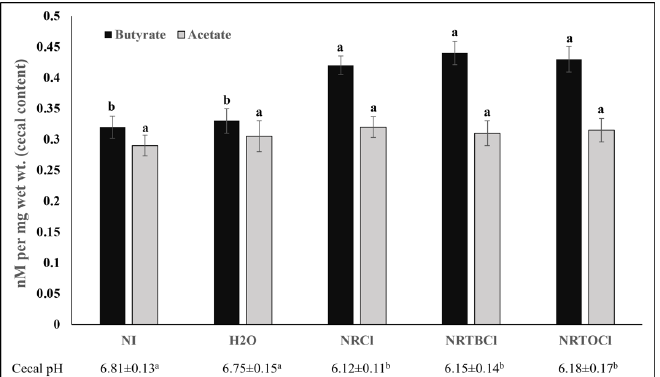
Figure 8. Cecal short-chain fatty acid (SCFA) composition and cecal pH. Values are the means ± SEM, n = 5. a, b Per SCFA (butyrate or acetate) and pH, treatments groups not indicated by the same letter within the same column are significantly different ( p < 0.05).